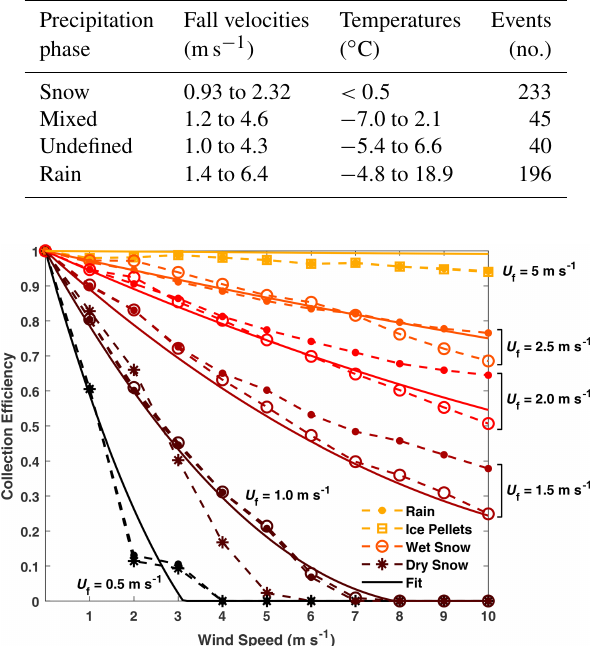
Figure 2. Flow simulation results for Geonor unshielded gauge col- lection efficiency based on wind speed and hydrometeor fall ve- locity for rain, ice pellets, wet snow, dry snow, and CFD transfer